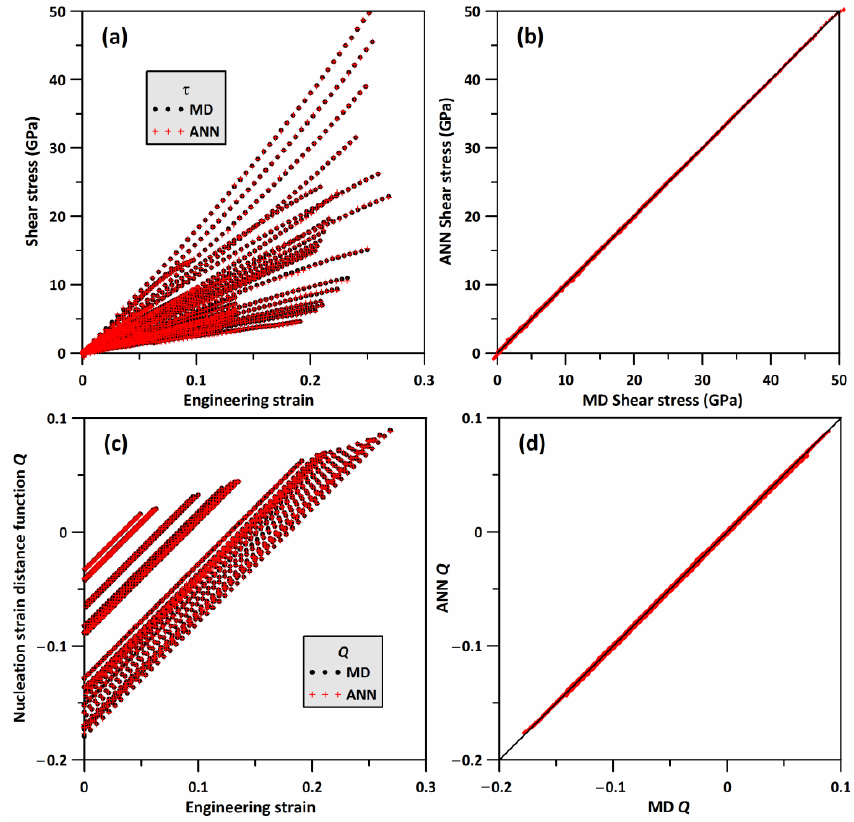
Figure 12. Results of ANN training: MD and ANN strain dependencies of ( a ) shear stress 𝜏 and ( c ) pressure 𝑃 , and ( b , d ) the corresponding correlation plots.